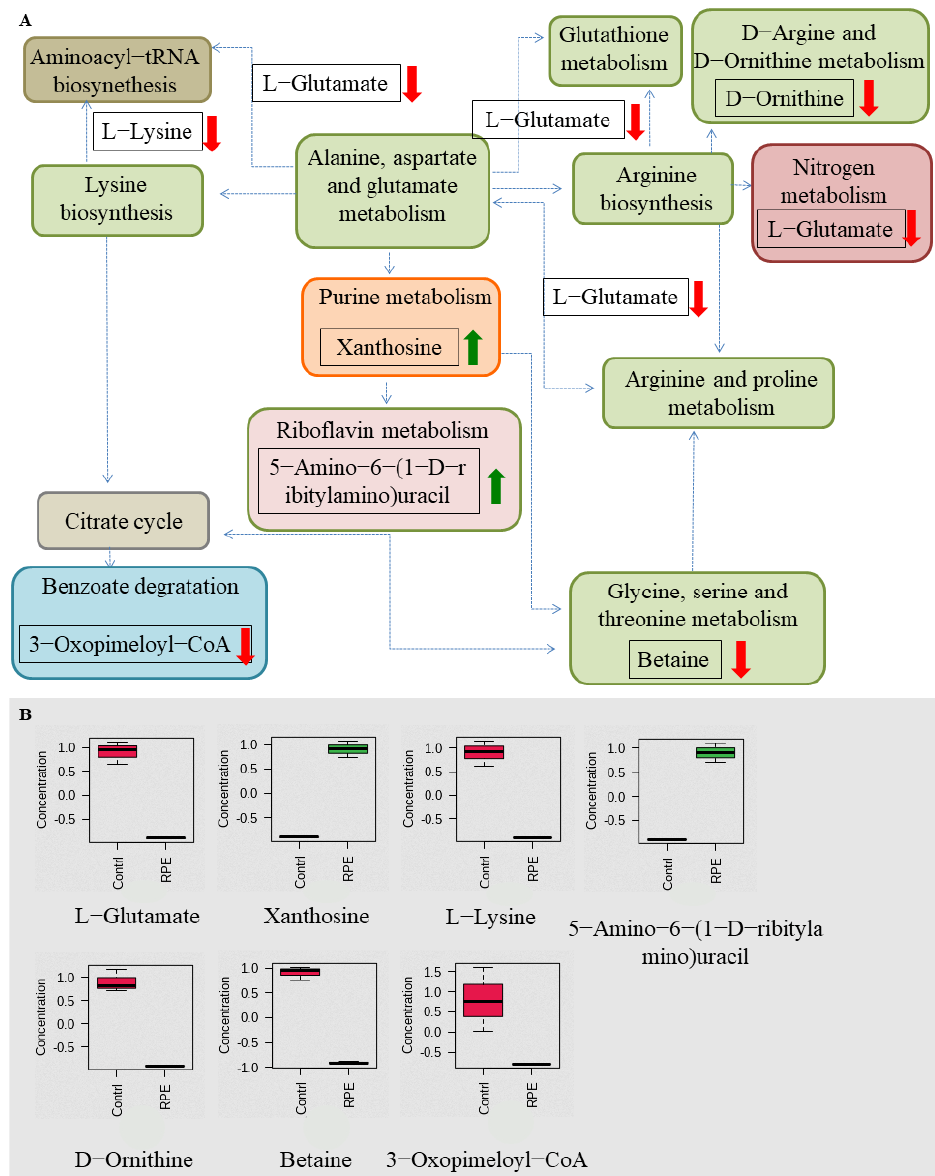
Figure 6. Related metabolic pathways and metabolites with significant changes following RPE treatment in S. aureus compared to the untreated group. ( A ) Green and red arrows indicate an increase and decrease abundance of metabolites, respectively. Different colors in the pathway represent different types of metabolism, while the same color represents the same type of metabolism, e.g., green are all amino acid metabolism. ( B ) Box plots for metabolites with significant changes involved in related metabolic pathways.